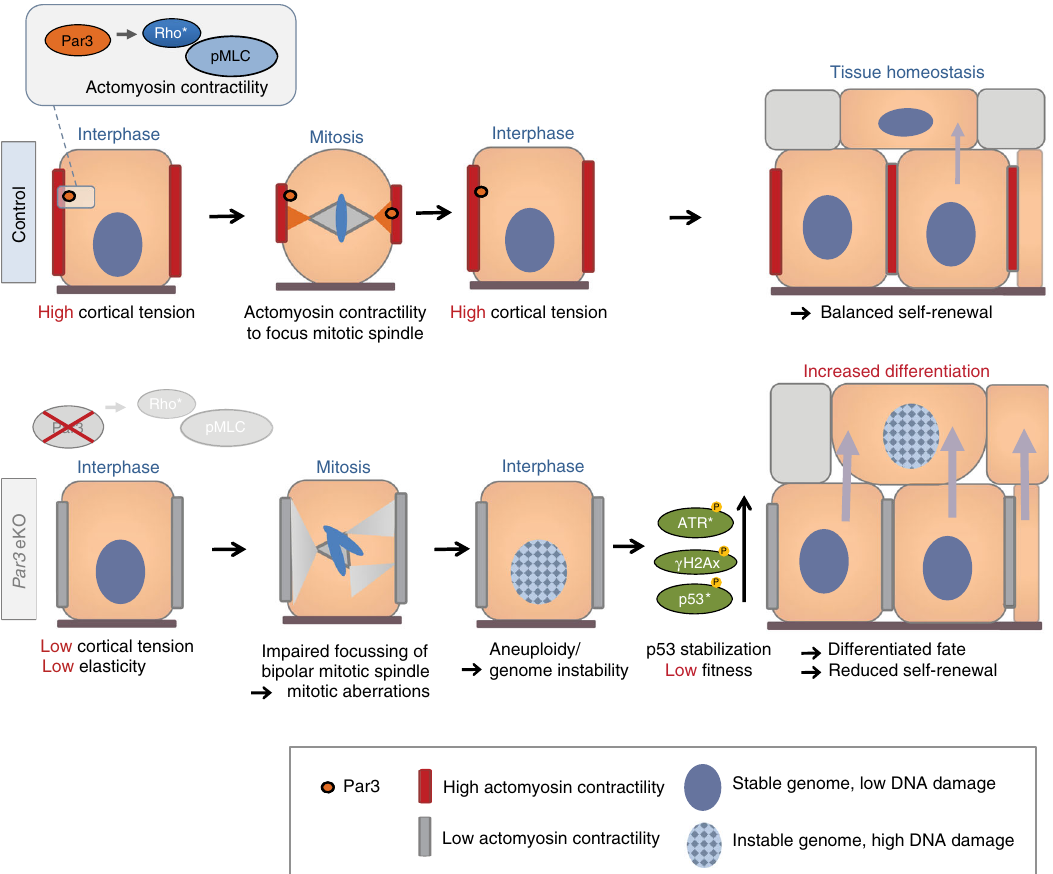
Fig. 8 Par3 directs epidermal fate decisions through coupling Rho/actomyosin contractility to mitotic fi delity. Model. Par3 regulates actomyosin contractility in a Rho-dependent manner. Loss of Par3 alters keratinocyte mechanics resulting in mitotic in fi delity and accumulation of DNA damage and p53, which in turn fuels differentiation and disturbs epithelial homeostasis. Restoring myosin activity in Par3-de fi cient keratinocytes is suf fi cient to normalize mitosis, and to prevent ectopic DNA damage, premature differentiation, and suprabasal fate. These data establish a role of Par3 in keratinocyte mechanics and mitotic fi delity. Rather than promoting asymmetric/perpendicular mitotic spindle orientation, altered polarity protein function in adult epithelia causes ectopic differentiated fate due to impaired cortical contractility that yields mitosis-related DNA damage and as consequence lower fi